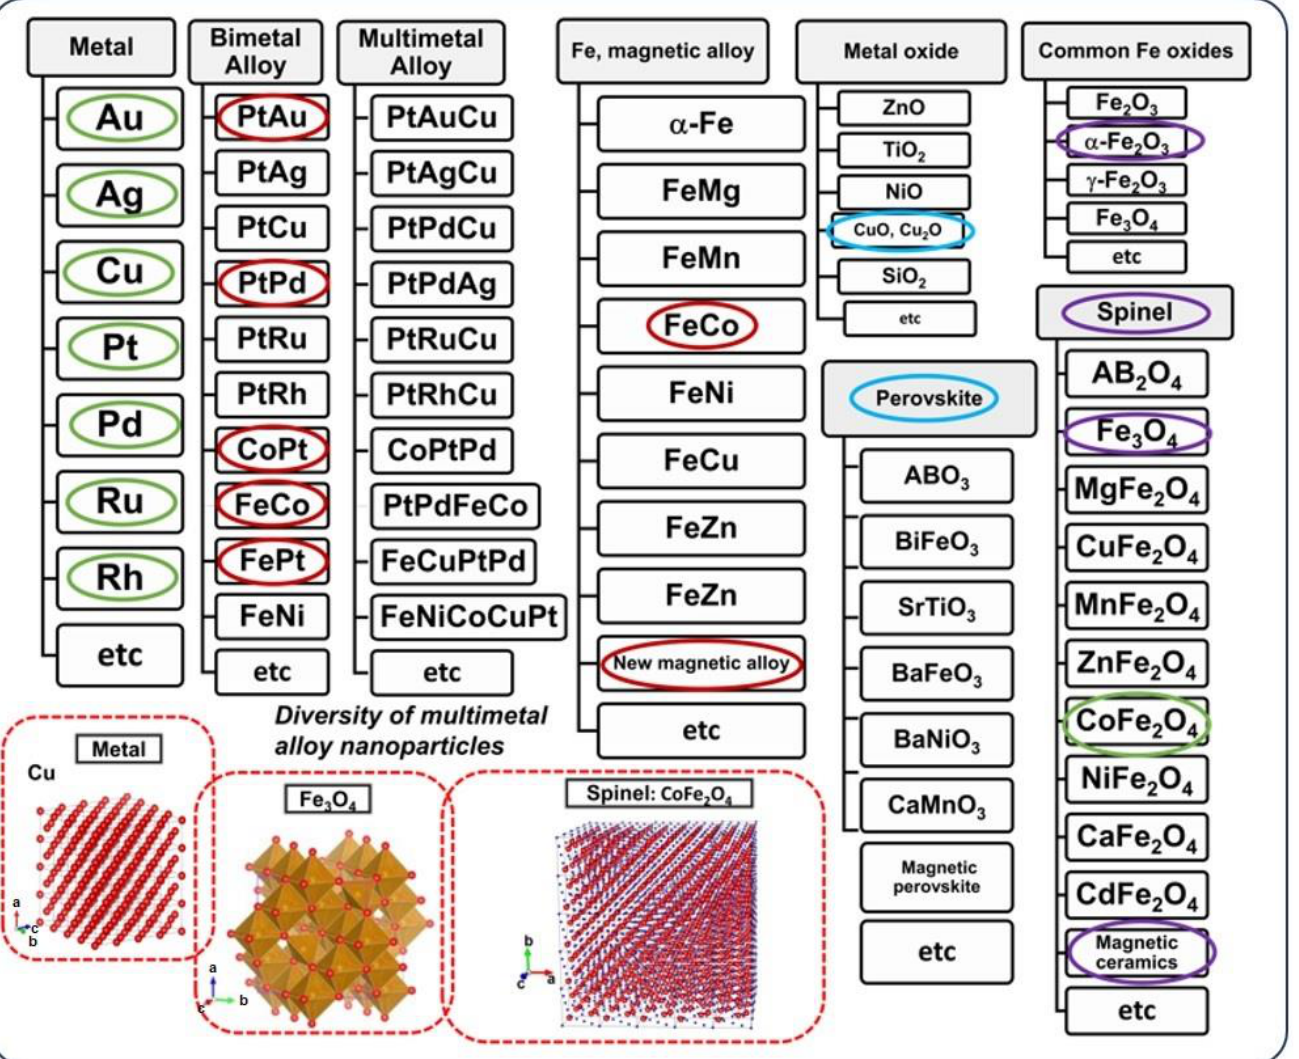
Figure 8. The great possibility in the controlled synthesis of metal, alloy, and AB 2 O 4 - or ABO 3 -type based oxide micro/nanostructures by both modified polyol methods and heat treatment. The polyol process opens a good opportunity of synthesizing multimetal nanoparticles for catalysis. In structural modifications, crystal structure of CoFe 2 O 4 spinel was clearly discussed in the tetrahedral sites and octahedral sites [52].